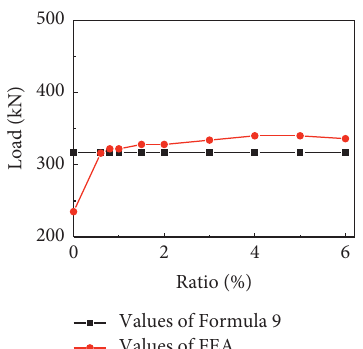
Figure 34: Values of formula (9) and FEA under changing of LR ratio of shear key (models FE14 to FE23).